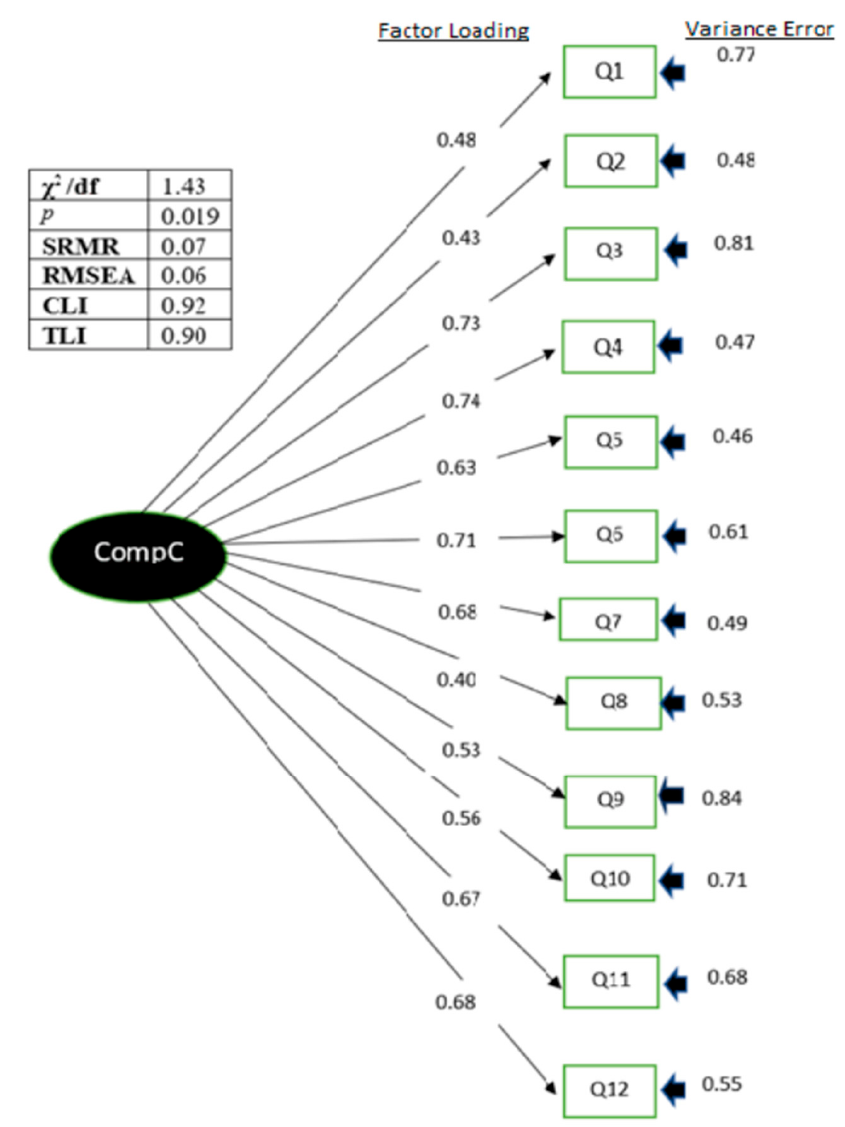
Figure 2. Path diagram of RAC-QM showing factor loadings and variance errors of each item.